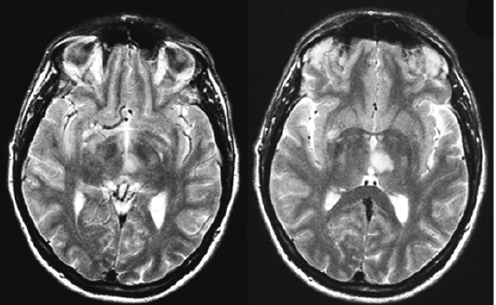
Figure 1: Transversal brain MRI (FLAIR) images of the patient AB showing the acute ischemic lesion in the medial dorsal nucleus of the left thalamus.